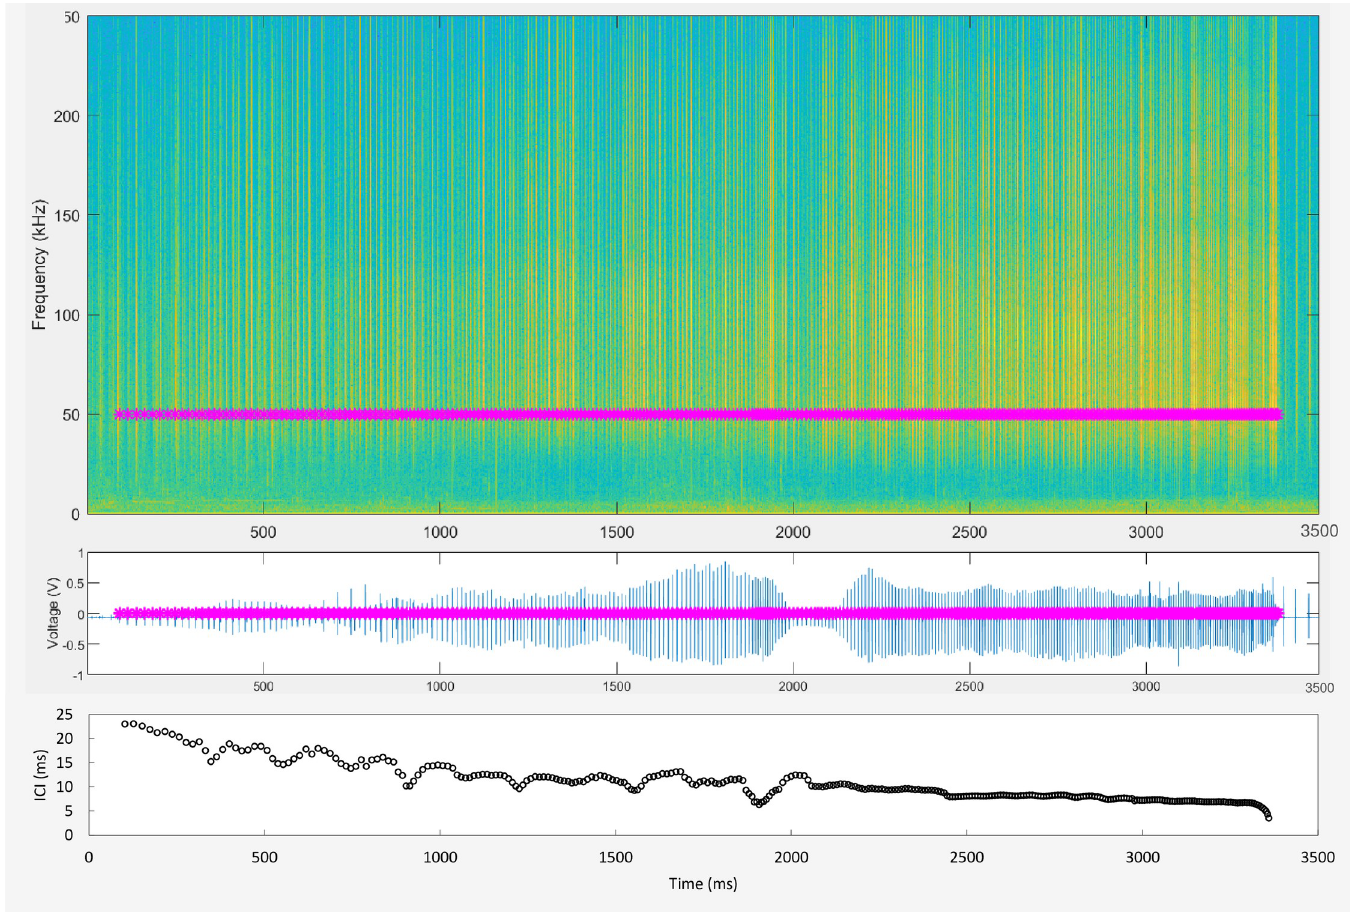
Fig 3. Spectrogram (upper panel) and waveform (middle panel) showing 3.5 s of data from DLBB14-05 emitting a feeding click train ending in a terminal buzz, and its corresponding inter-click interval (ICI) measured with script Callmark (lower panel). Purple asterisks mark each click peak time, with time zero equates to 14 hrs and 47 min since the beginning of the recording, or 5:08 am AKDT on 29 August 2014. Note clicks from another beluga were excluded at 700 to 900 ms and again at 2900 to 3500 ms.